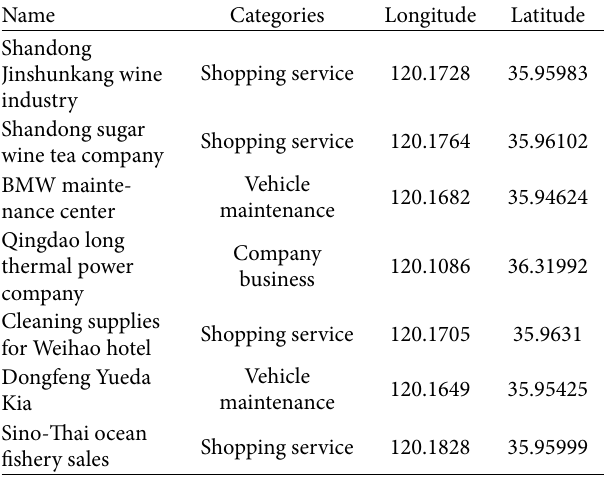
Figure 1: Population identification roadmap. Table 3: Data sample of POI in Baidu